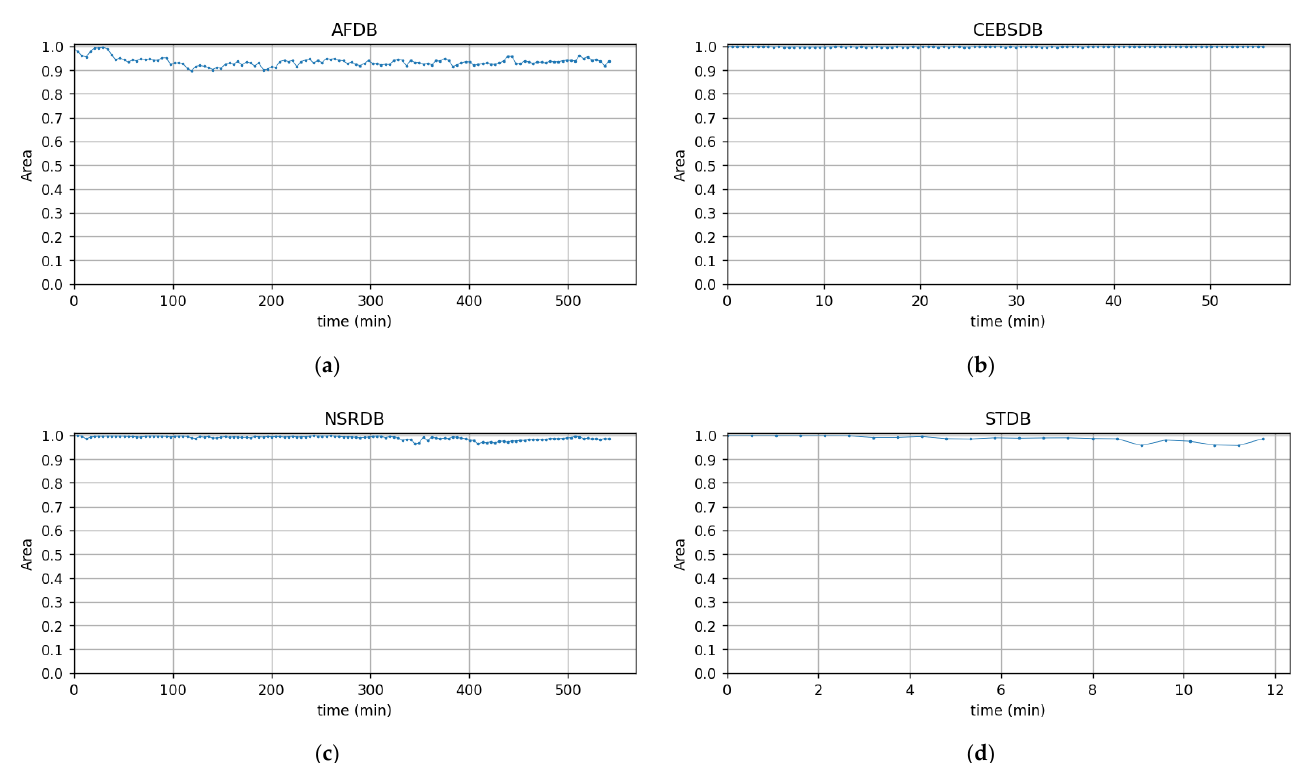
Figure A6. EER of individual verification is plotted against time separation for: ( a ) AFDB, ( b ) CEBSDB, ( c ) NSRDB, ( d ) STDB.